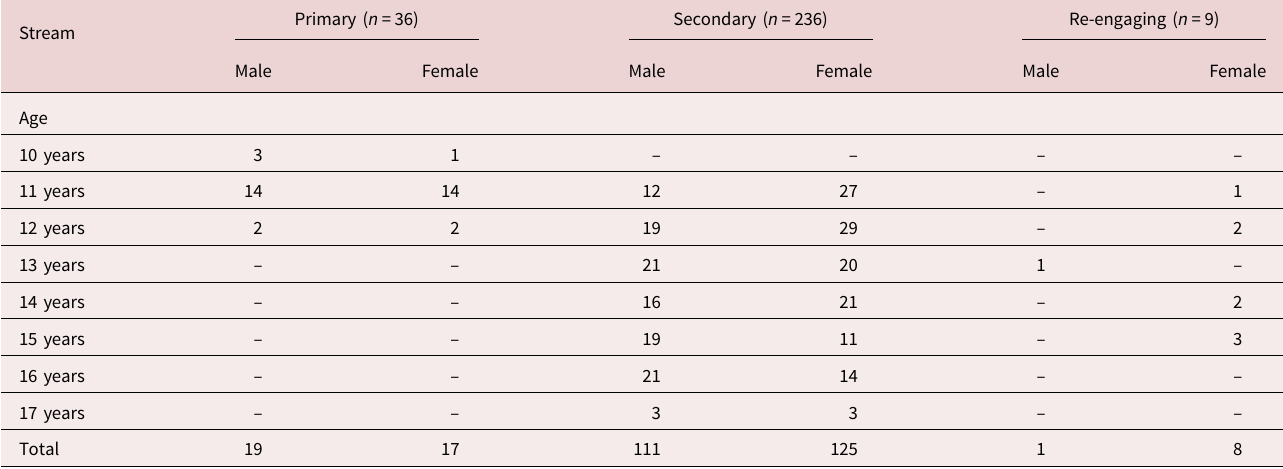
Table 2. Participant demographics